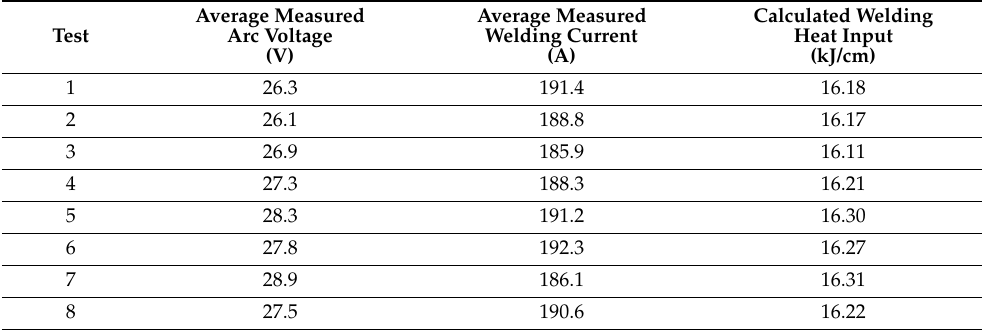
Figure 11. Average value of the width, penetration and dilution rate of the welds: ( a ) different ultrasonic excitation voltages with a constant frequency of 30 kHz; ( b ) different pulse frequencies with a constant voltage of 40 V. Table 4. Measured values of the welding parameters during the UFP ‐ UWW process.